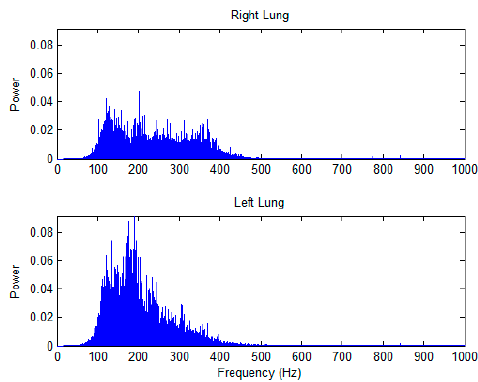
Figure 5. The power spectra of the right and left lungs of a female subject. Because the auscultation site of the left lung was close to the heart, the power in the low frequency range would be higher than that at the right lung.